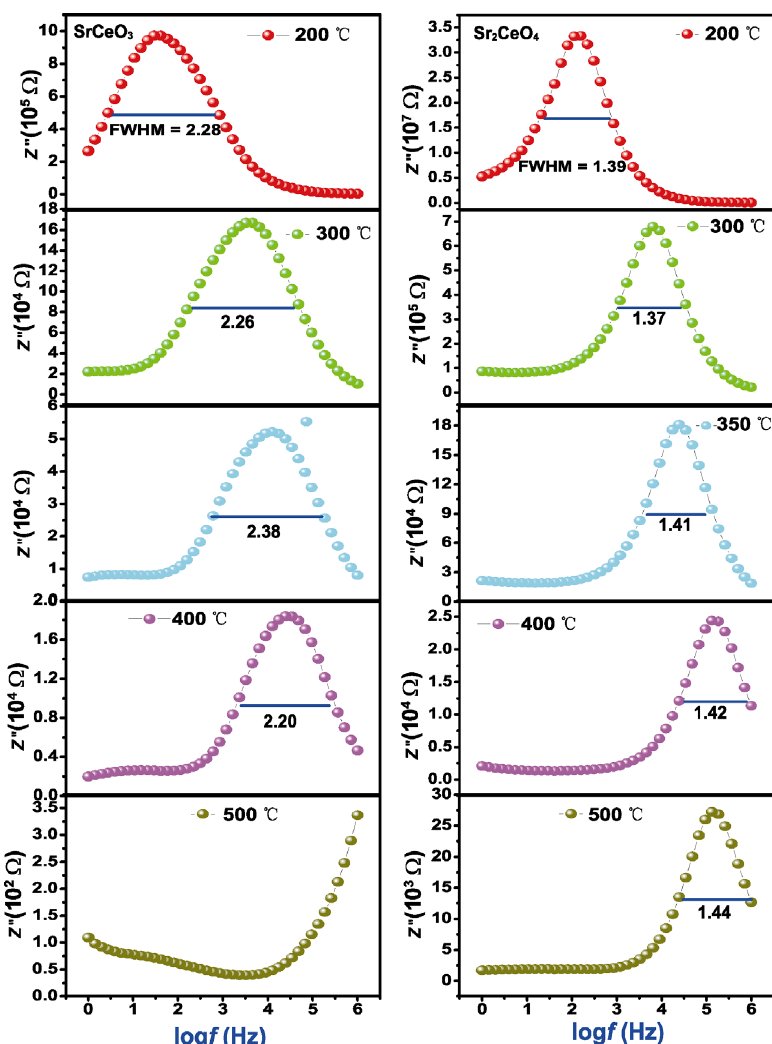
Fig. 7 Variation of imaginary part of impedance ( Z ʺ ) with logarithm of frequency at different temperatures. FWHM represents the value of the full width at half-maxima.